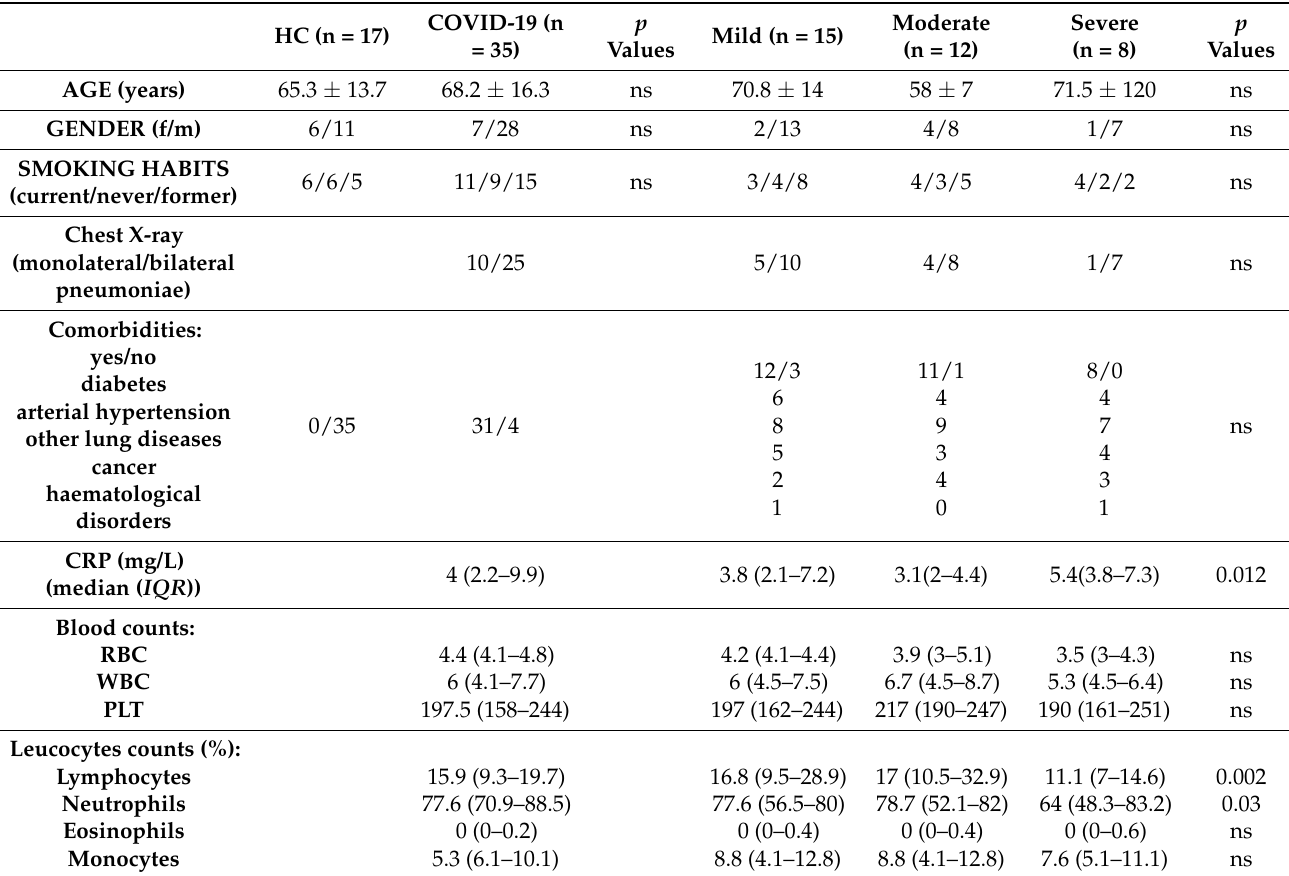
Table 1. Demographic data and blood parameters of COVID-19 cohort and healthy